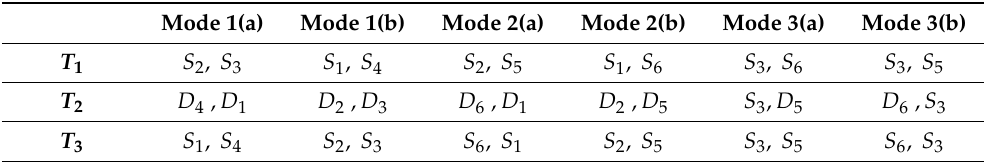
Table 4. Modes (1), (2), and (3) switching